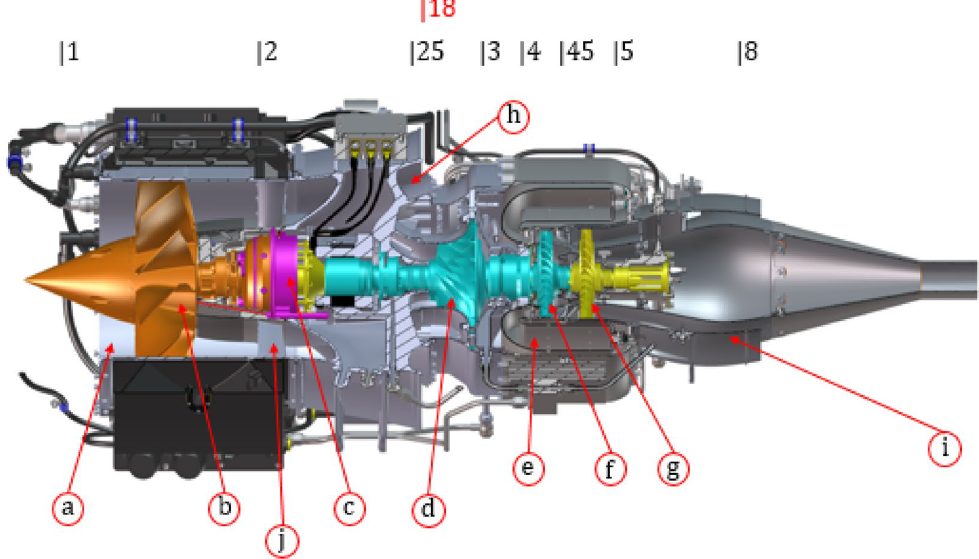
Figure 1. Cutaway illustration of DGEN 380 30,32 engine: ( a ) engine inlet, ( b ) fan, ( c ) gearbox, ( d )